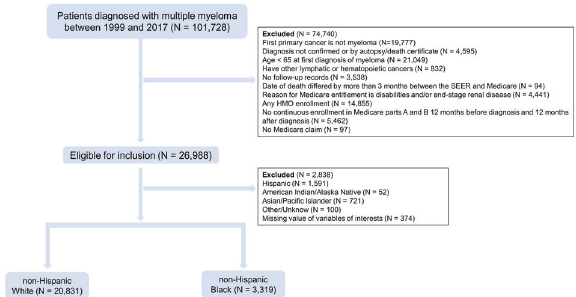
Fig. 1 Patient selection. Study cohort selection fl ow diagram in SEER-Medicare